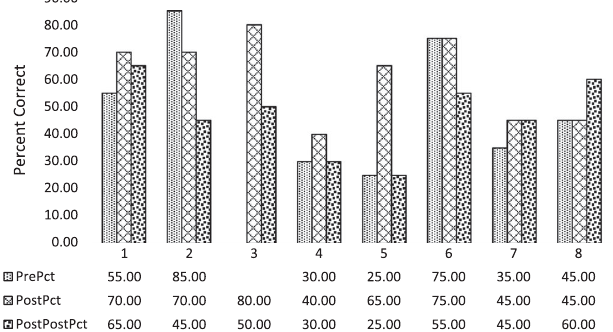
FIG. 6. Three snapshots (pre, post, and post-post) of PSVT-Rot percent correct by 6th grade teacher (teachers numbered 1 –